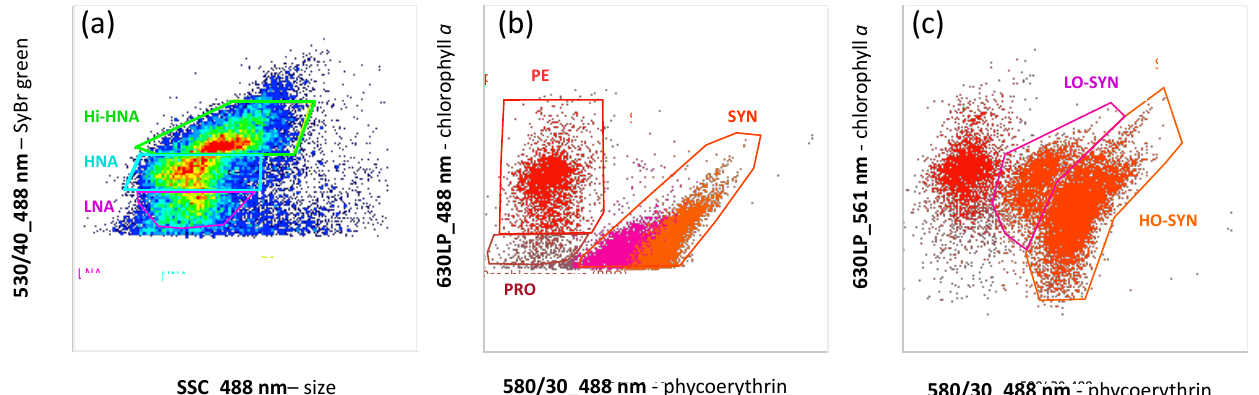
Figure 2. Example (day 23 M3 1m) of flow-cytometry cytogram dot plot of (a) naturally non-fluorescent bacterioplankton groups dis- criminated by their DNA content (SYBR green-induced fluorescence in arbitrary units (a.u.) vs. cell size (side scatter), after 488nm laser excitation); (b) phototrophic groups discriminated by their chlorophyll a content (related to the red fluorescence intensity (a.u.) vs. phycoery- thrin related to the orange fluorescence intensity (a.u.) after 488nm laser excitation); (c) low-orange (LO-SYN) and high-orange (HO-SYN) Synechococcus -like subgroups separated by their chlorophyll a content (after 561nm laser excitation) vs. their phycoerythrin content (after 488nm laser